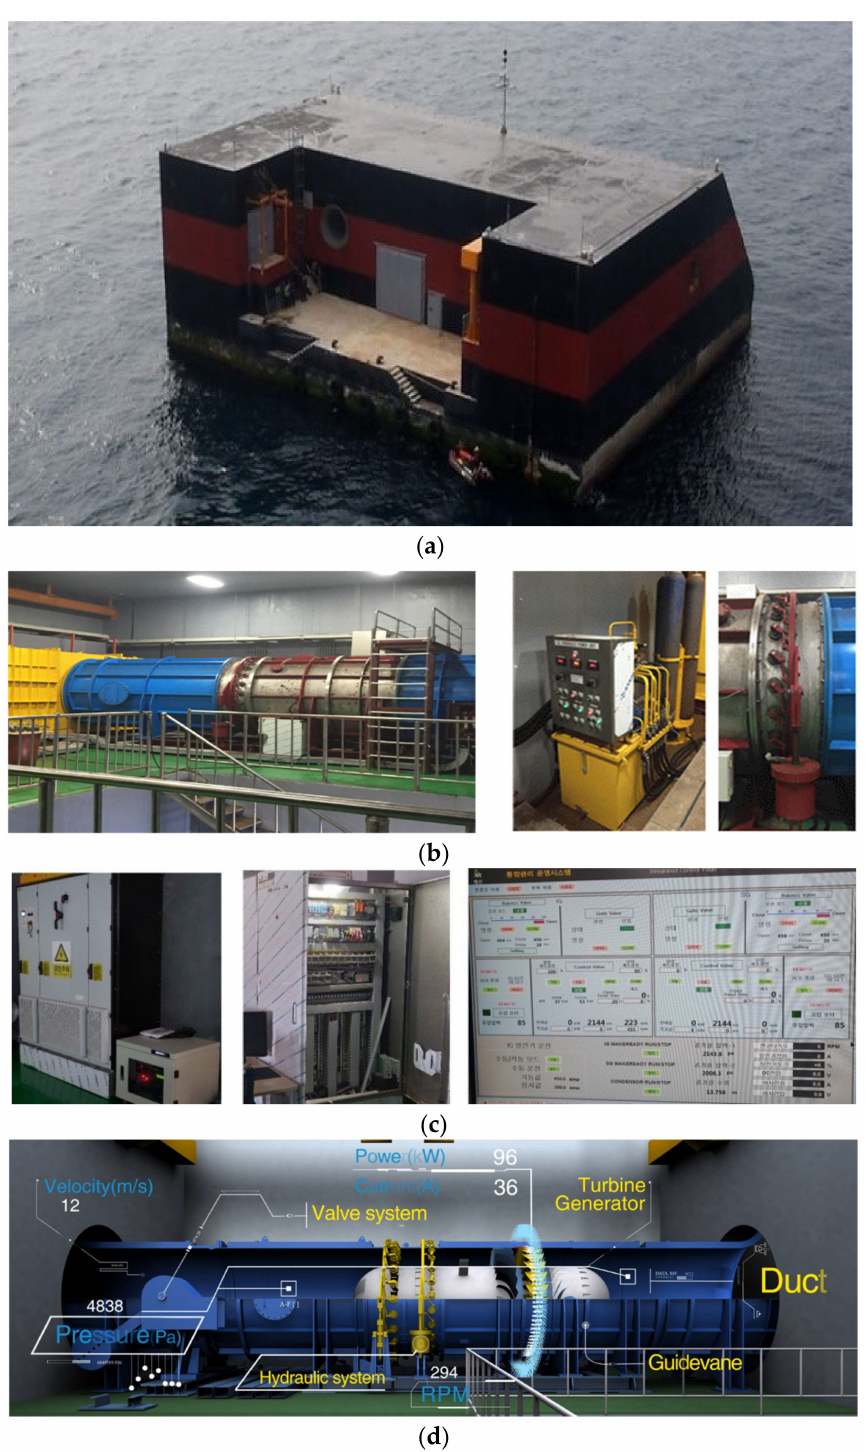
Figure 8. ( a ) Photograph of the OWC-WEC west of Jeju, South Korea. ( b ) Photographs of the turbine system and valve system. ( c ) Power converter/PLC and control program. ( d ) Measurement sensor data